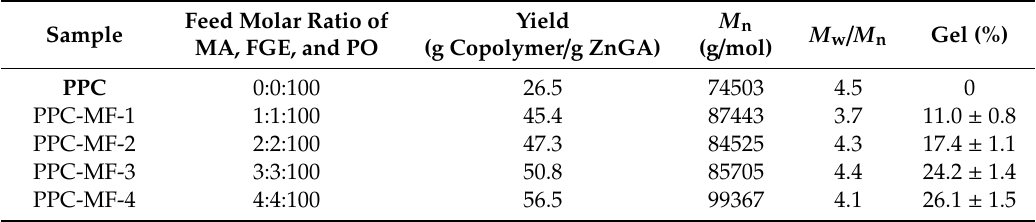
Table 1. The results of copolymerization .